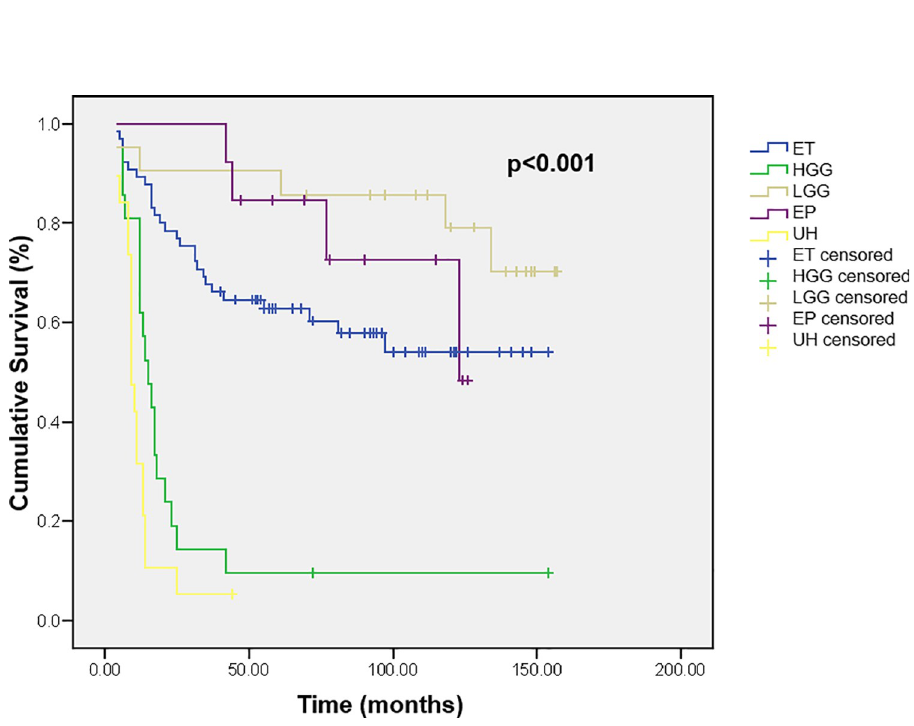
Fig 4. Cumulative survival of children with brain tumors according to tumor histopathological type. ET– embryonal tumors, HGG–high-grade glioma, LGG–low-grade glioma, EP–ependymoma, UH–unknown histopathological